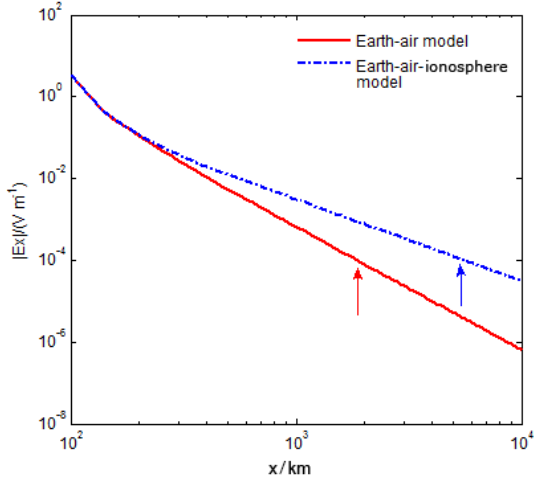
Figure 7. The Wenchuan source producing electric field | E x | de- cay curves as a function of the distance along x axial direction with an ionospheric effect (blue dotted line), as well as without an iono- spheric effect (red line). The electric field | E x | = 0.1mVm − 1 is labeled with a red and a blue